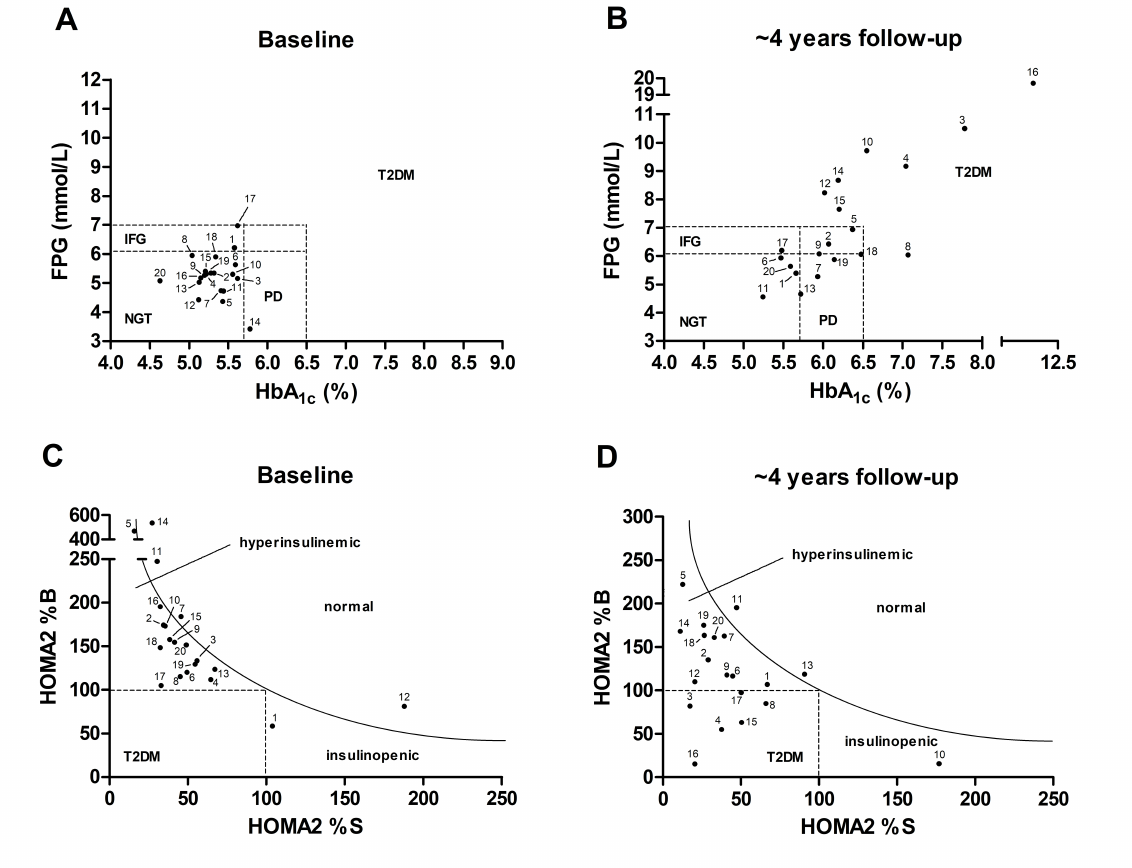
Figure 4. Categorization of twenty individuals with prediabetes (ADA criteria) by diagnostic parameters at baseline ( A , C ) and follow-up studies ( B , D ) using FPG versus HbA 1c levels ( A , B ) or HOMA2 %B versus insulin sensitivity HOMA2 %S values ( C , D ). Thresholds of FPG and HbA 1c levels (dashed lines) relied on the current diagnostic criteria of WHO and ADA for normal glucose tolerance (NGT), impaired fasting glucose (IFG), prediabetes (PD), and type 2 diabetes mellitus (T2DM). Updated homeostasis model assessment (HOMA2) separated individuals in normal, diabetic (100% values), insulinopenic or hyperinsulinemic state. The numbers indicate the prediabetes samples (Tables S14 and